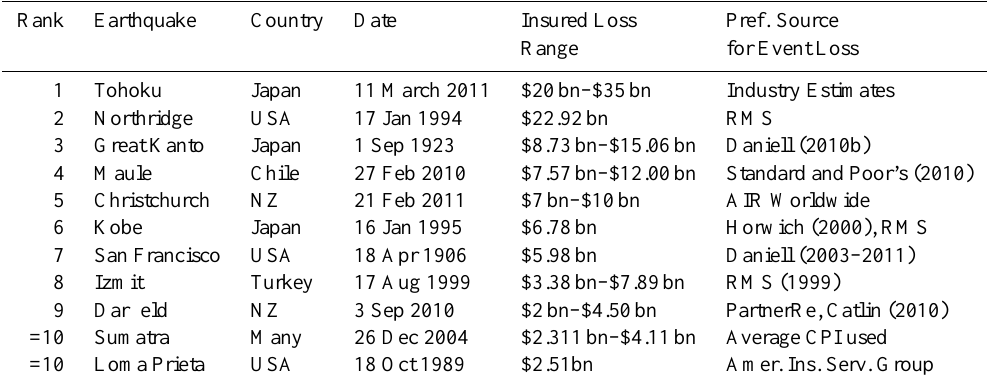
Table 6. List of highest insured losses (1900–2011) in 2011 Country CPI adjusted $ international.